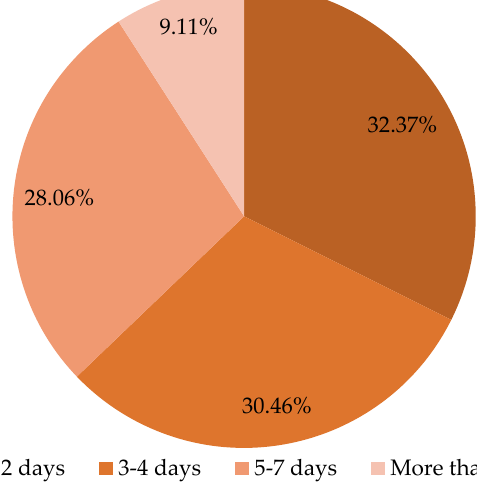
Figure 2. The presentation of different bread storage duration groups.